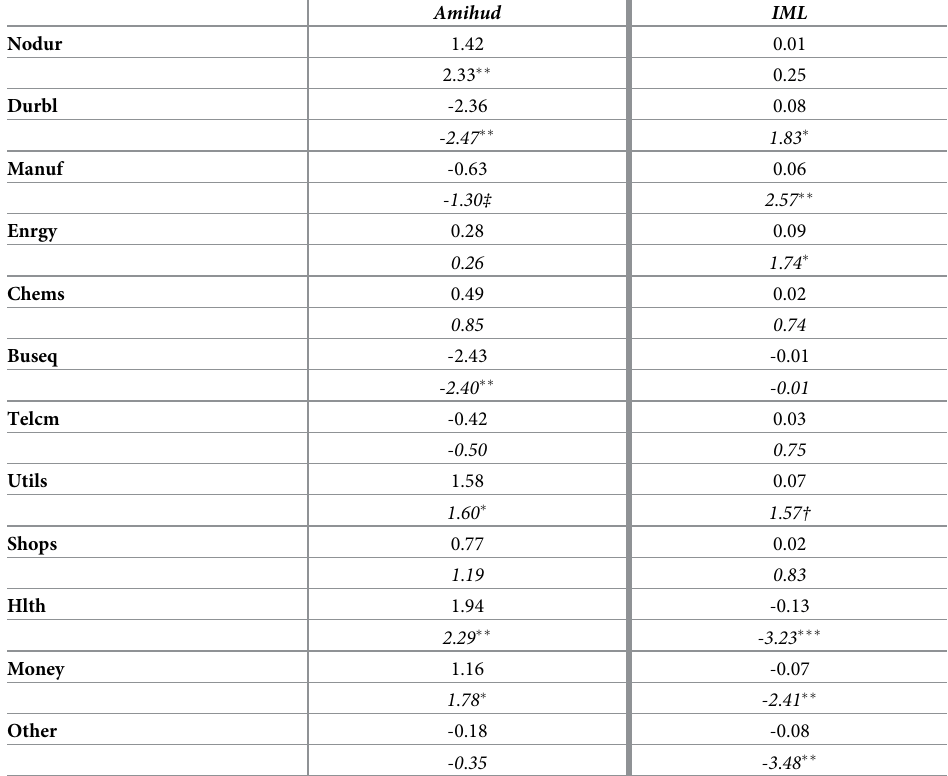
Table 5. OLS exposures of the 12-sector portfolios to Amihud illiquidity ratio and IML in the augmented Fama and French five-factor